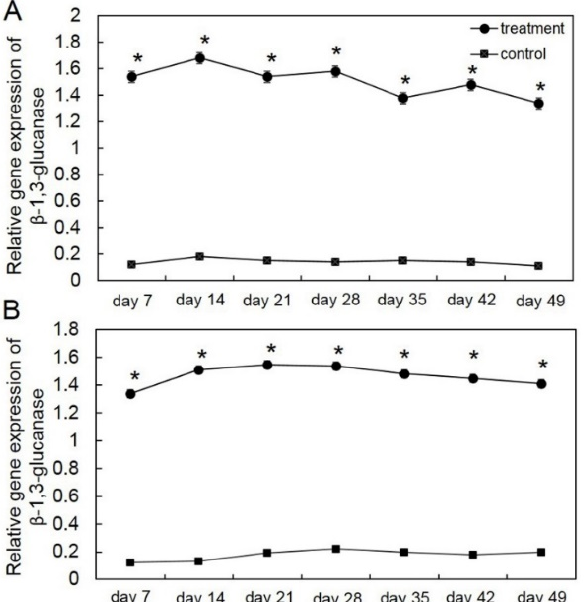
Figure 2. Relative gene expression of β -1,3-glucanase in the first crop ( A ) and second crop ( B ) through reverse transcription quantitative PCR (RT-qPCR) in Trichoderma asperelloides PSU-P1- treated muskmelon plants and control plants. * Indicates a significant difference between treatment and control according to Student’s t -test with p < 0.05.